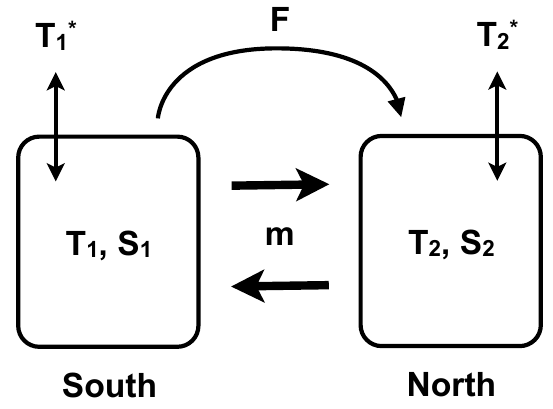
Fig. 1. Schematic view of our conceptual two box model for the Atlantic Meridional Overturning Circulation. Griesel and Morales-Maqueda, 2006; Schewe and